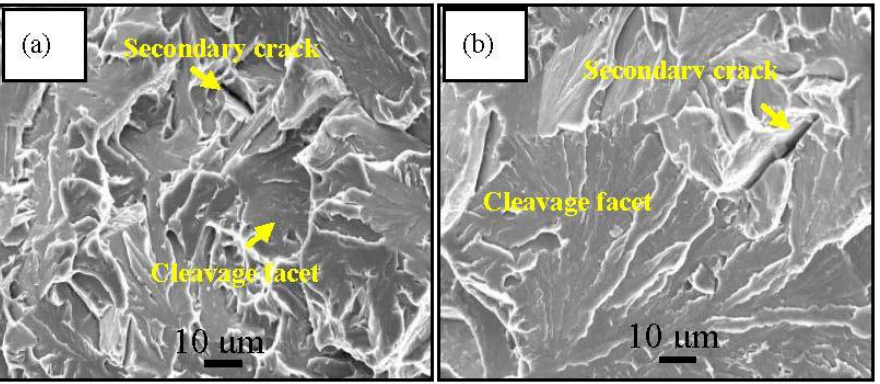
Figure 9. SEM images of fracture surfaces of the specimens with different heat inputs: ( a ) 30 kJ/cm; ( b ) 60 kJ/cm.